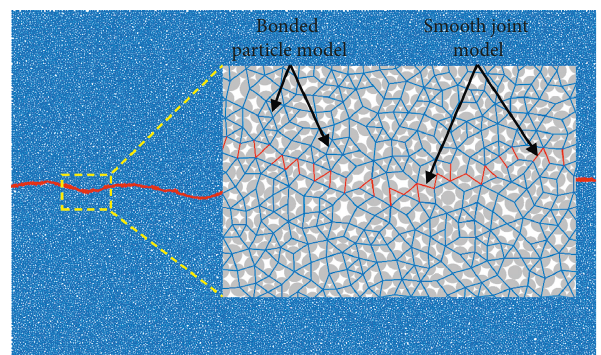
Figure 8: Numerical joint model established by the smooth joint model.